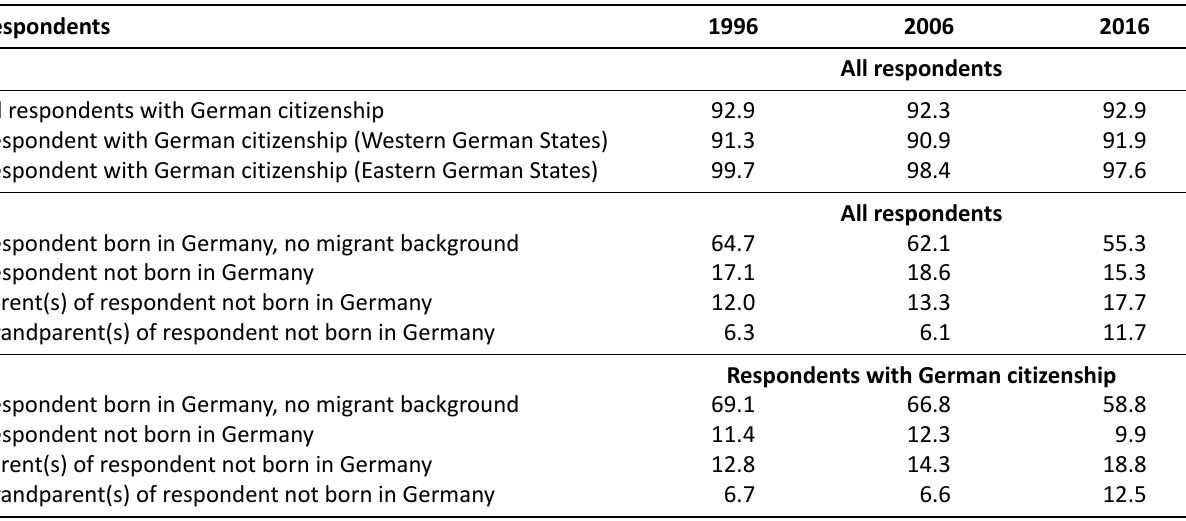
Table 1. Proportion of respondents in the ALLBUS data with German citizenship and immigration background (in percent). Source: GESIS